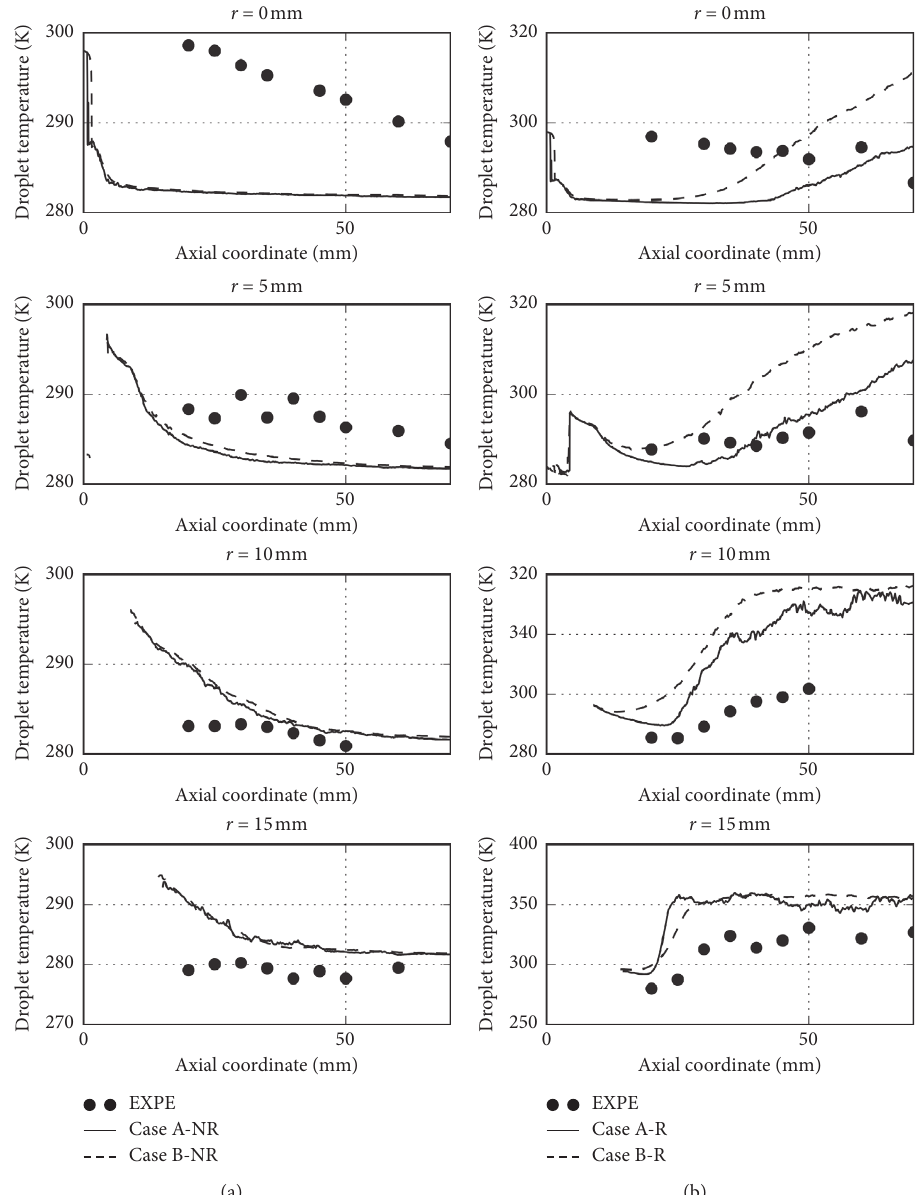
Figure 29: Axial profiles of droplet temperature for nonreacting (a) and reacting case (b). Symbols: experiments, solid line: case A dashed line: case